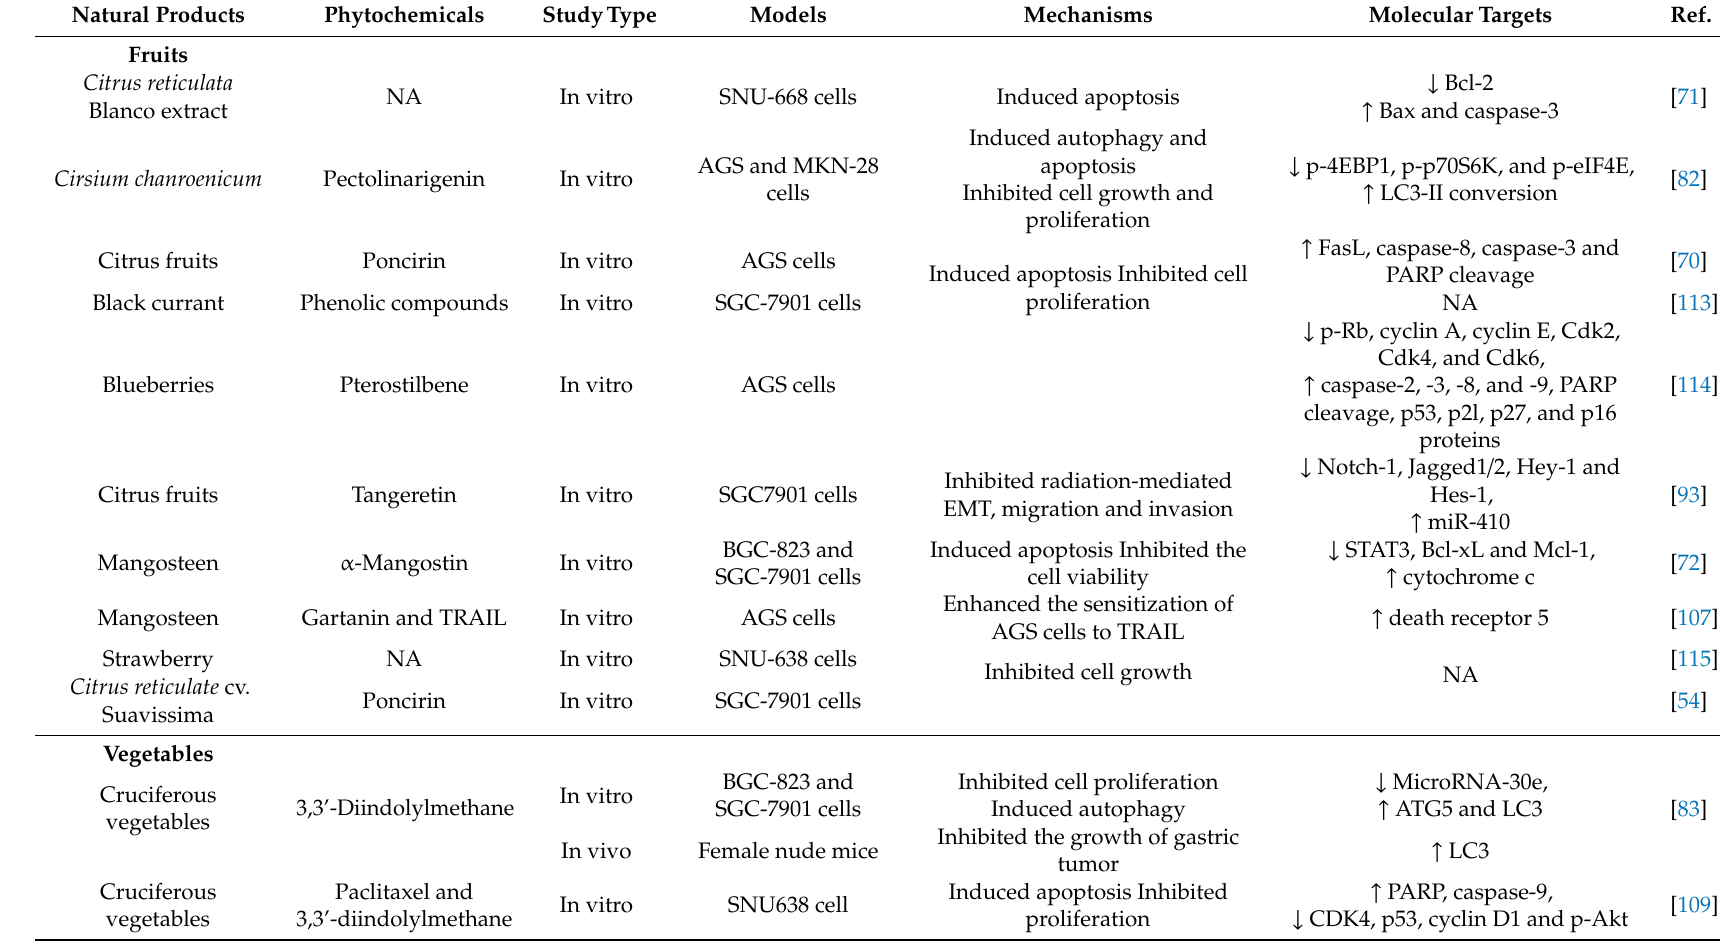
Table 2. The e ff ects of phytochemicals against gastric cancer from experimental